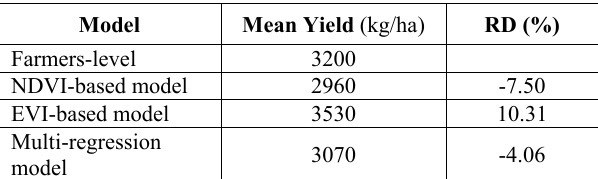
Table 3 : Mean paddy yield (kg/ha) estimated from different yield models and their corresponding